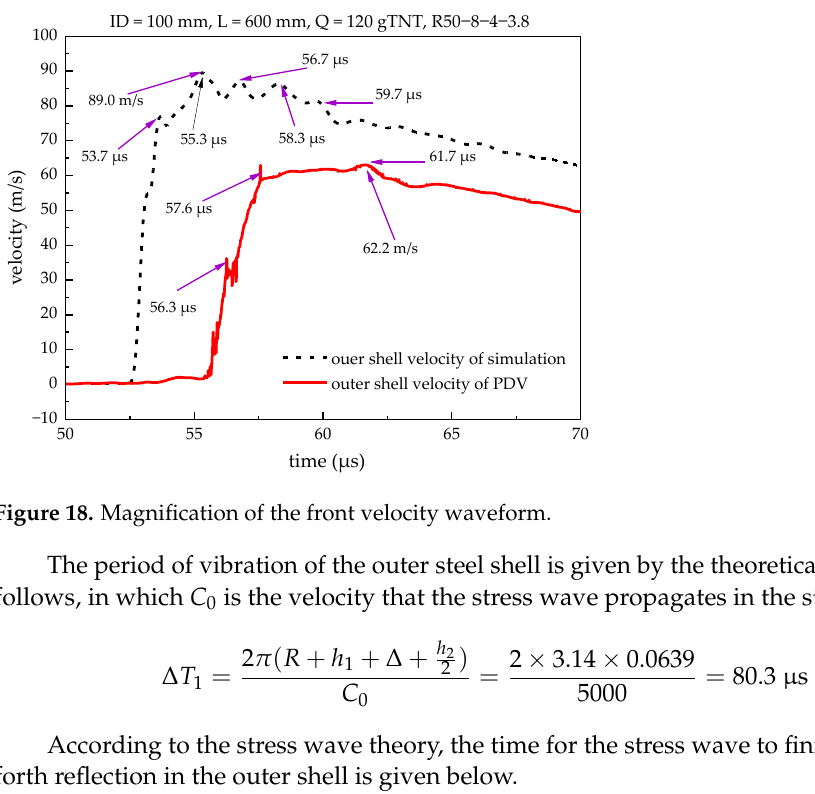
Figure 17. Velocities of PDV measurement and simulation.